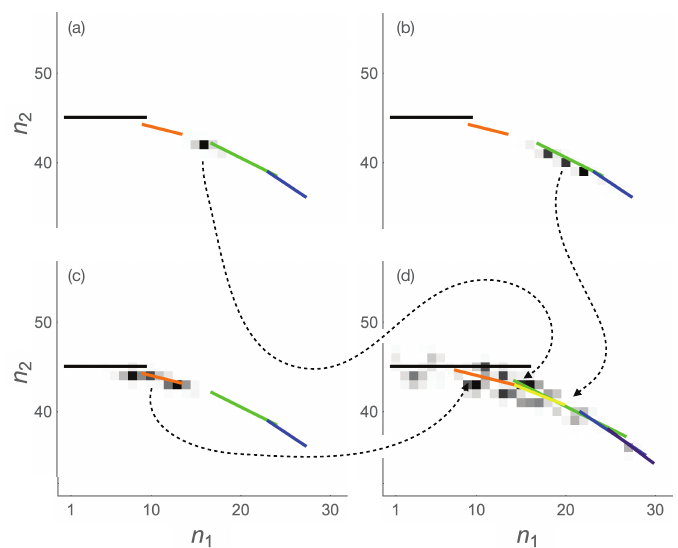
Figure 3: An example of two separate quantum nonlinear resonances, 2 : 1 (b) and 4 : 1 (c), separated by a KAM gap (a), at ε = 0.02, overlap and fuse into a single, broad eigenstate (d) that also comprises the already existing 1 : 0 and 3 : 2 resonances and newly emerged 4 : 3, 5 : 2, 6 : 1, and 5 : 4 ones, at ε = 0.06 (see caption of Fig. 2 for the color scheme and for the value of ( m ) 〉| 2 of the individual unperturbed states Grey scale reflects contributions |〈 λ | ( n , n 1 2 | ( n ) 〉 to the perturbed state | λ 〉 . For clarity, on each of the four plots, the , n 1 2 grey scale spans the whole range between white and black, white correspond- ing to zero overlap and black corresponding to the maximal value of the overlap, |〈 λ | ( n ) 〉| 2 = 0.614, 0.315, 0.194, and0.070 for (a), (b), (c), and (d) max , n n 1 , n 2 1 2